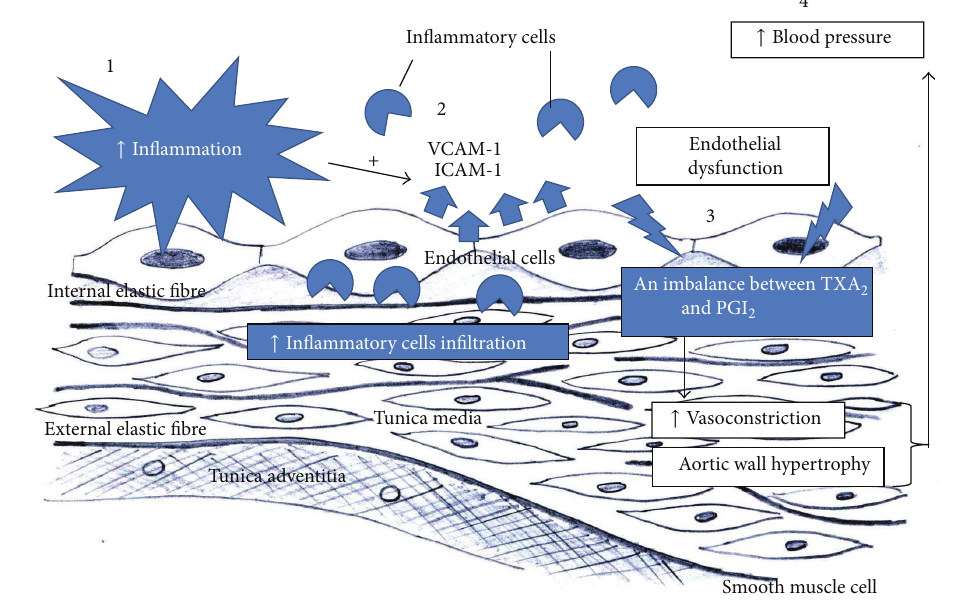
Figure 1: (1) Inflammatory stimuli induce the expression of cellular adhesion molecules such as vascular cell adhesion molecule-1 (VCAM-1) and intracellular adhesion molecule-1 (ICAM-1) on endothelial cells. (2) Increased VCAM-1 and ICAM-1 expressions recruit more leukocytes to the site of inflammation. (3) Leukocytes infiltration and production of cytokines lead to oxidative stress and inflammation, which result in endothelial dysfunction, affecting the balance of synthesis between vasodilators and vasoconstrictors. The imbalance favours vasoconstriction and adverse vascular remodelling, (4) consequently leading to elevation of blood